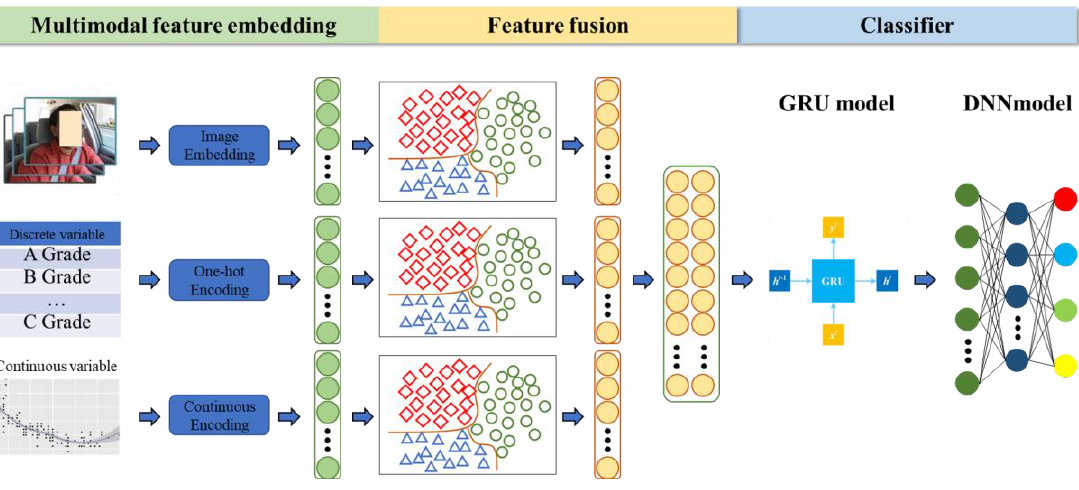
Figure 2. Multimodal feature